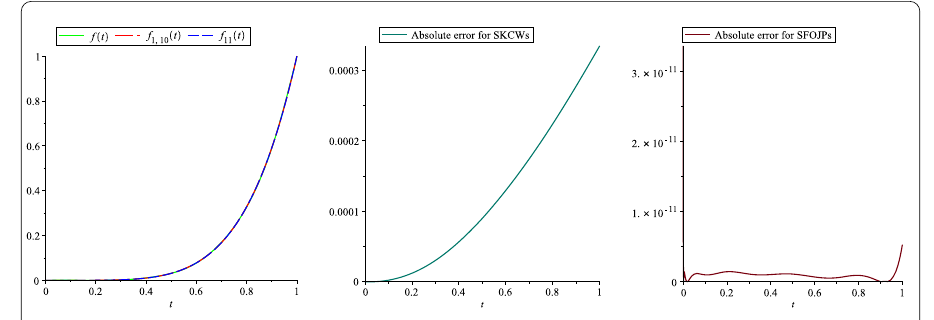
Figure 2 Graphs of the obtained results at the interval [0,1) by the SKCWs and SFOJPs methods with k = 1, M = 10, N = 11, λ = 1 , θ = 3 , ϑ = 3, for Example 6.2 2 2